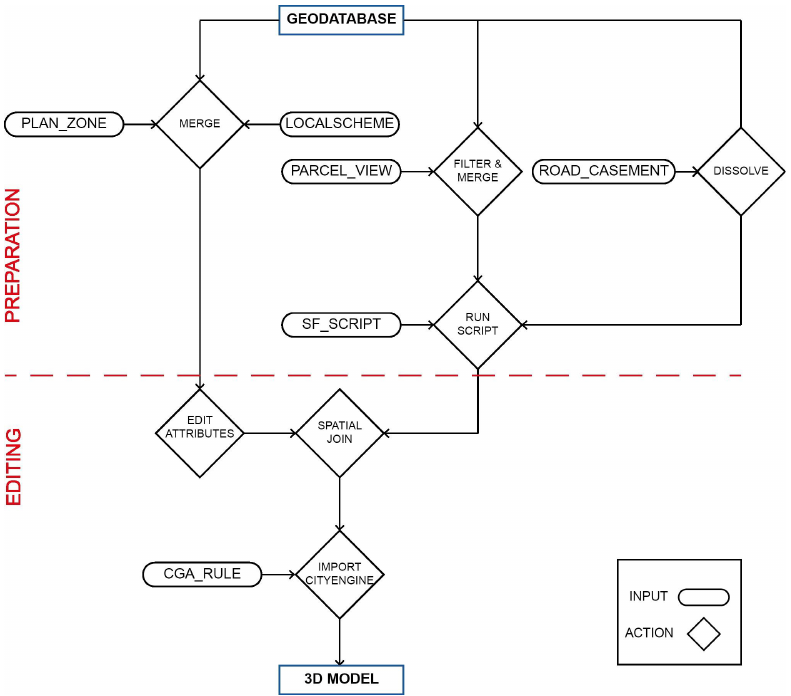
Figure 1. The workflow to produce 3D models from 2D plans.